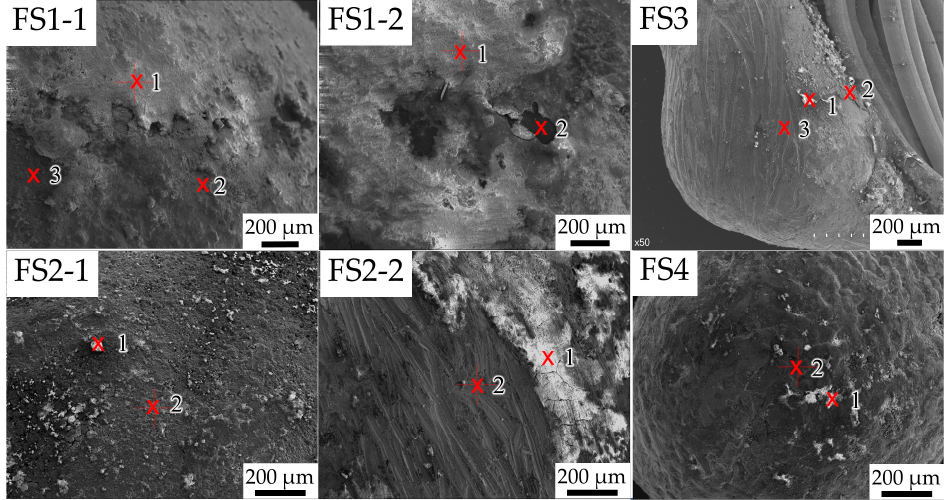
Figure 2. Surface morphology of the molten marks on copper wire.